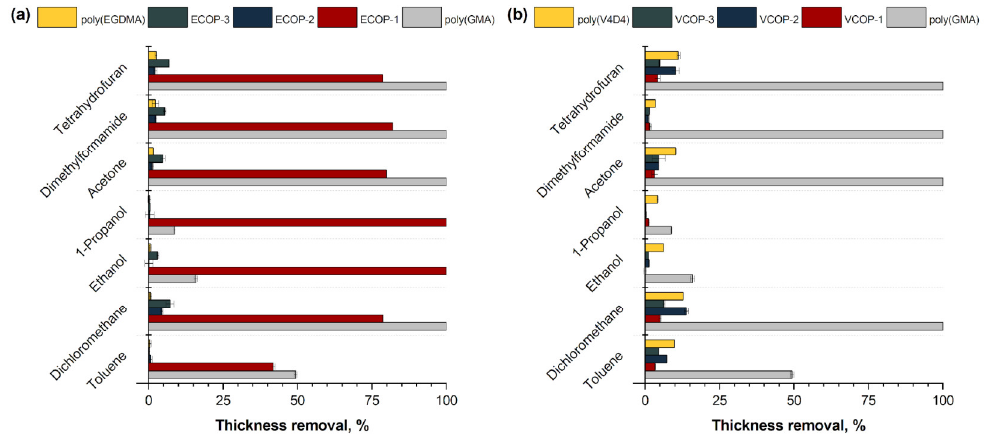
Figure 5. Relative change in film thickness of ( a ) poly(GMA), poly(EGDMA) homopolymers and their copolymers, and ( b ) poly(GMA), poly(V4D4) homopolymers and their copolymers in various solvents.